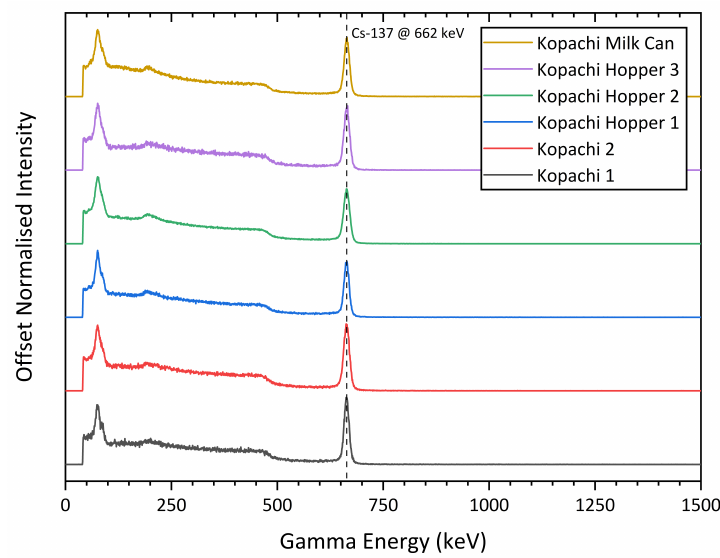
Figure 9. Comparison of gamma spectra captured by the CC-RIAS for different deployment locations in the CEZ, showing consistency in contamination across the exclusion zone. The photopeak at 662keV identifies 137 Cs as it decays into 137 Ba from its metastable isomer 137m Ba. CC-RIAS confirms 137 Cs is the only gamma-emitting fallout isotope of significance remaining in the CEZ as of 2019. All measurements made at a distance of 1 - 10cm from the surface, with normalised peak heights to facilitate comparison.